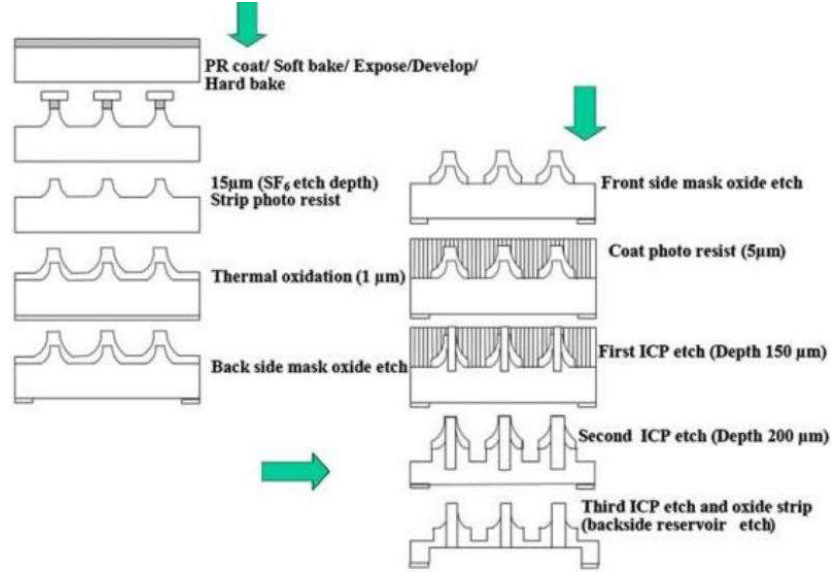
Figure 13. Fabrication process of hollow silicon out-of-plane microneedles [41].